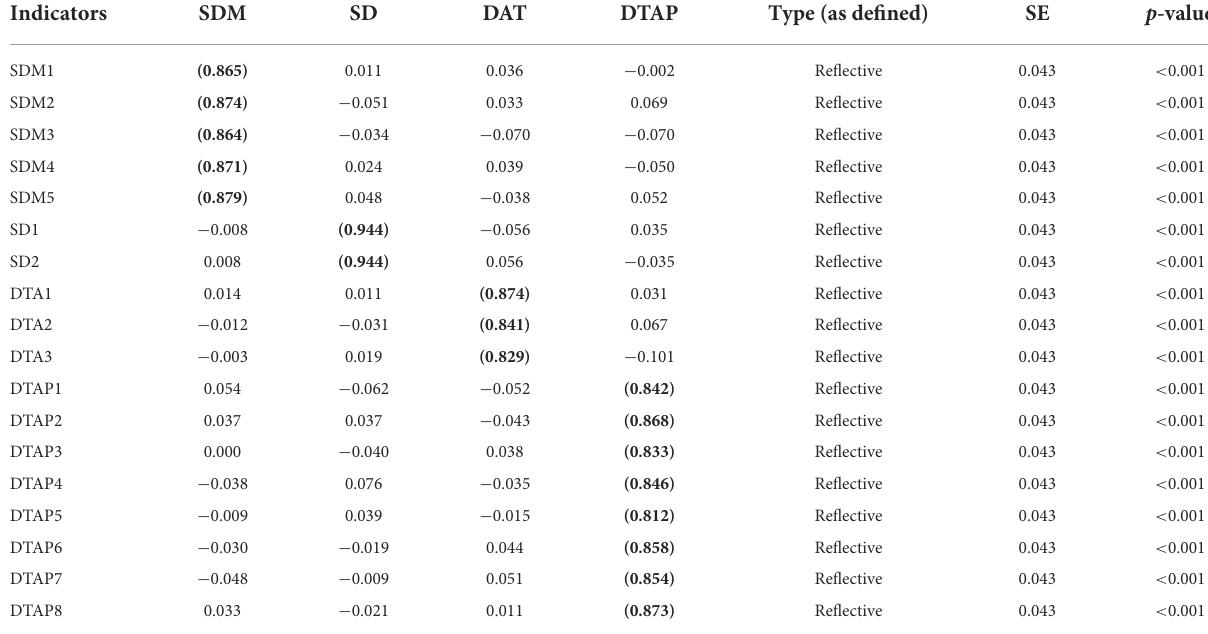
TABLE 2 Combined and cross-loadings for the outer